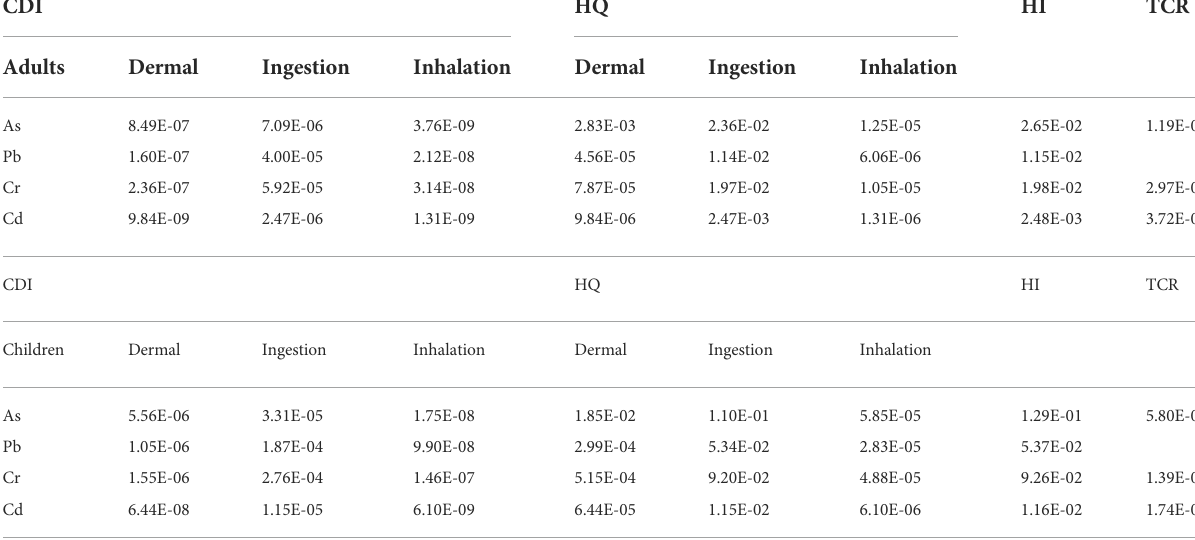
TABLE 4 Value of different toxicity indexes in the sediment of the Rupsha